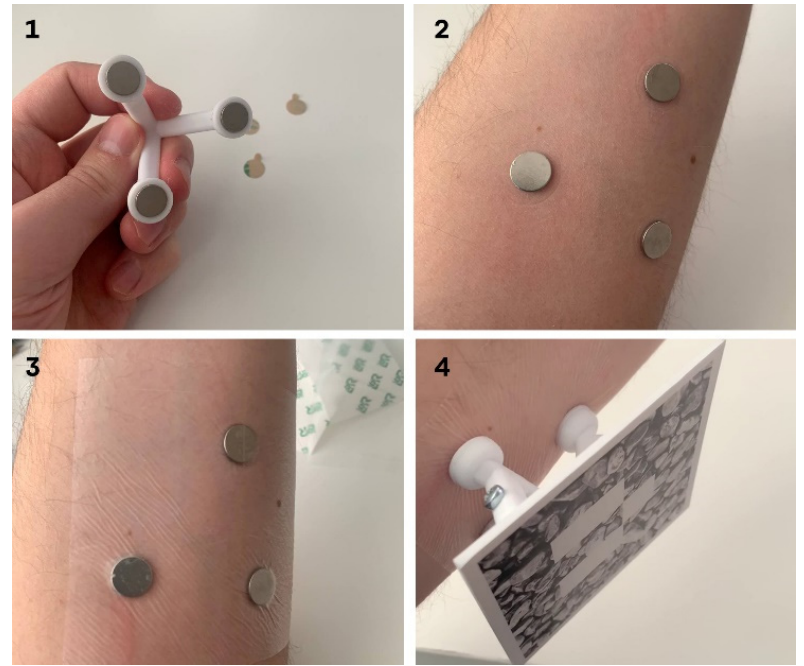
Figure 9. First stage—magnets are placed on the guide frame’s sockets. The protective cover